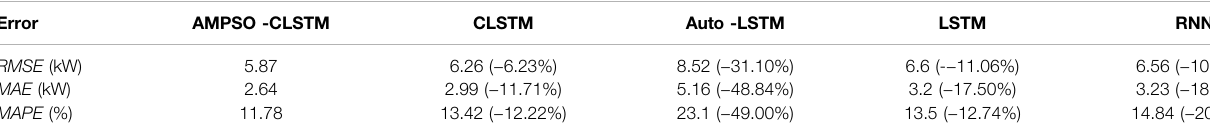
TABLE 6 | PV power forecasting error.